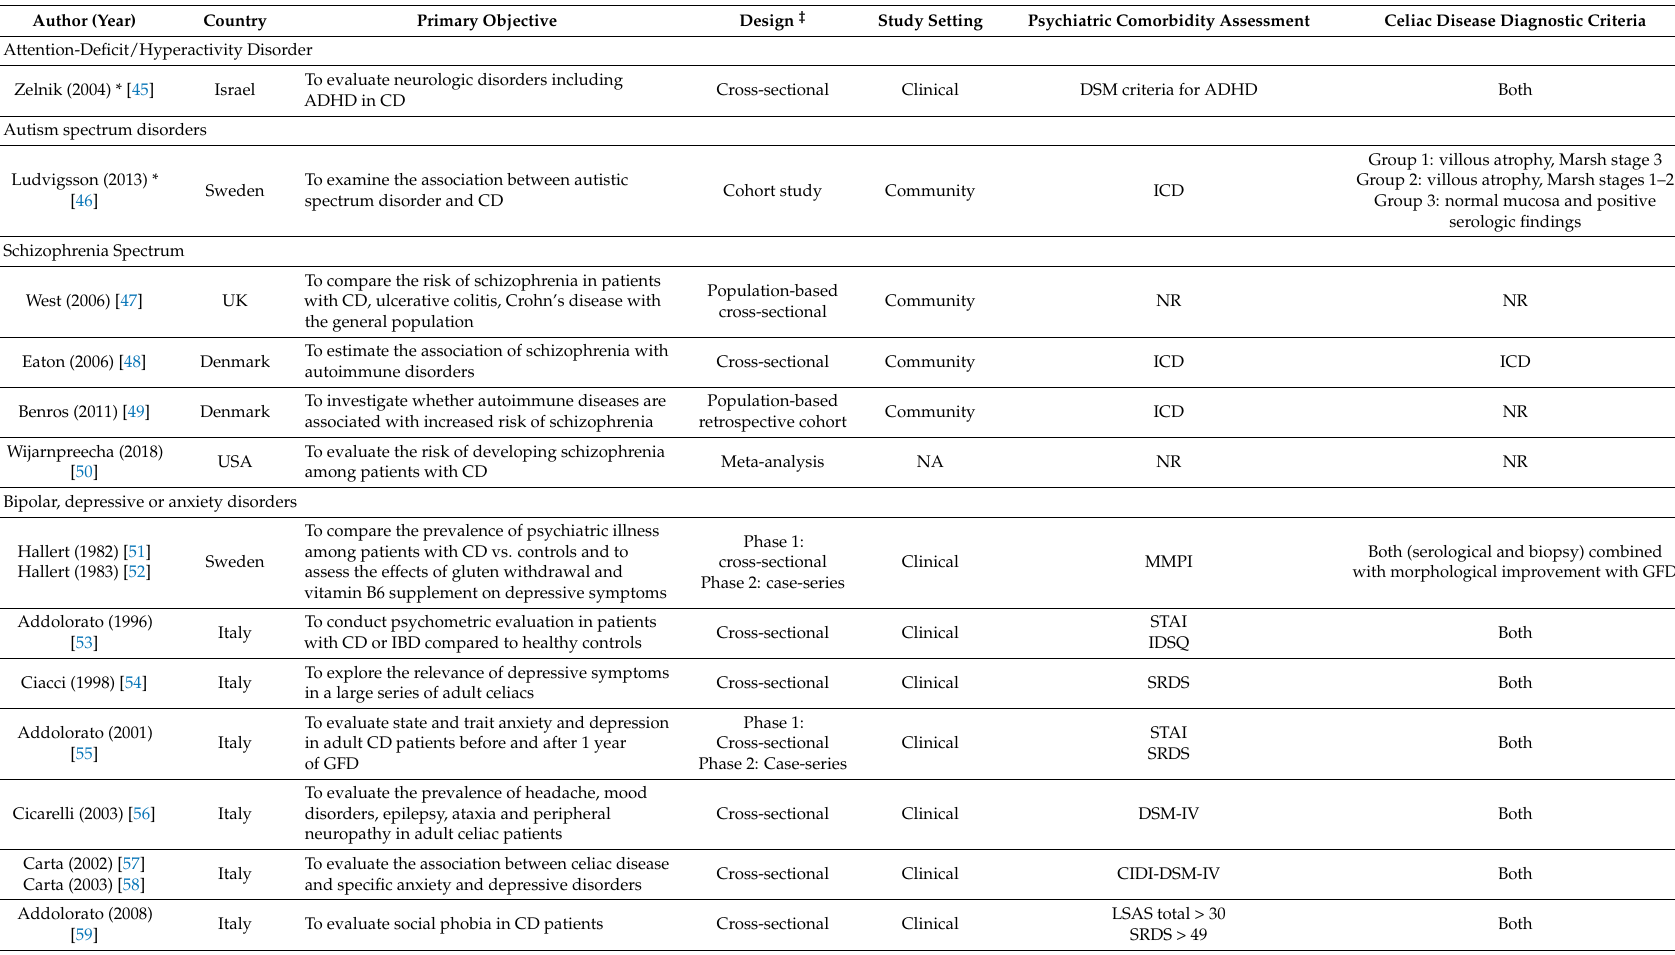
Table 3. Objectives and design of studies evaluating the association between gluten-related disorders and psychiatric disorders in